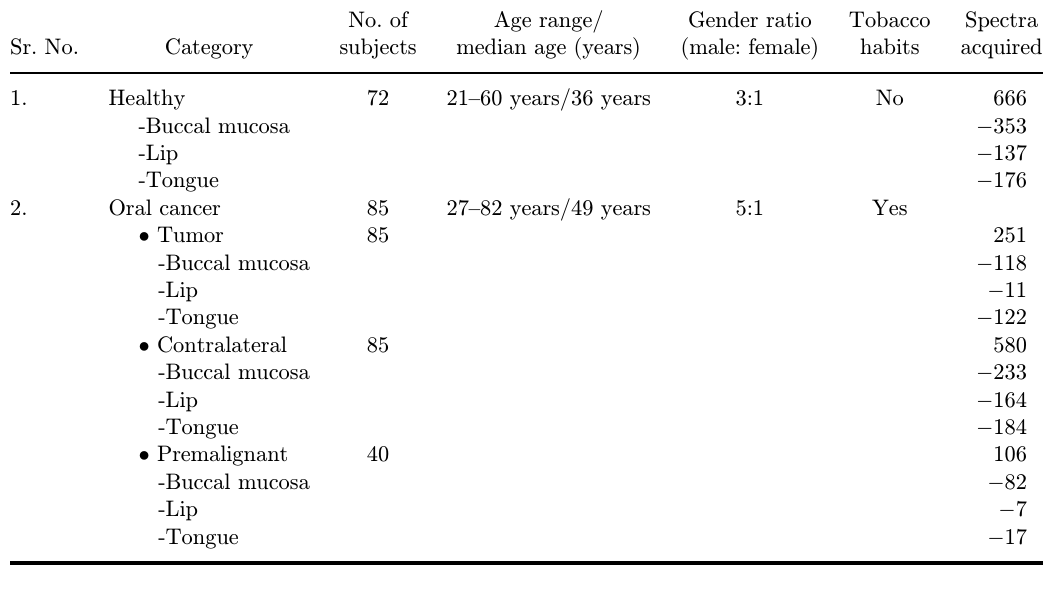
Table 1. Summary of subject accrual and demographics.